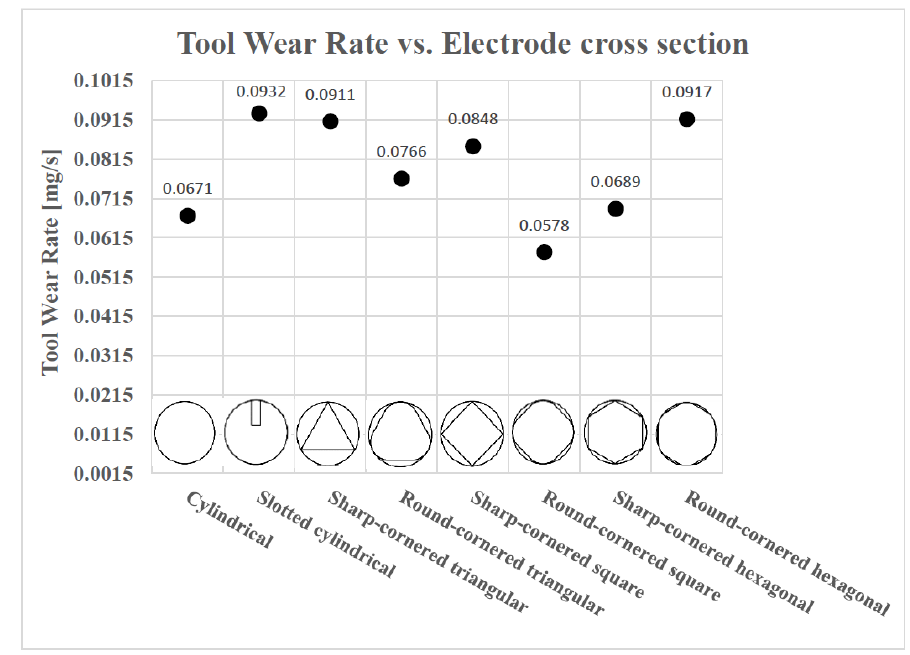
Figure 6. The Tool Wear Rate (TWR) for different shaped electrodes.